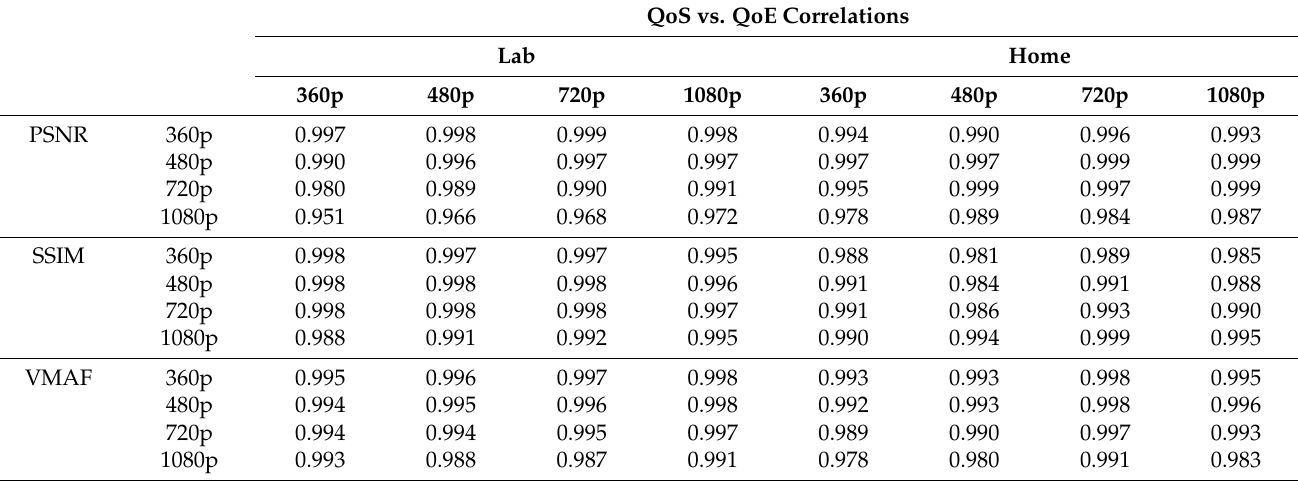
Table 12. Correlations between QoS and QoE values (in the lab and home) for VP9 encoded video. QoS vs. QoE